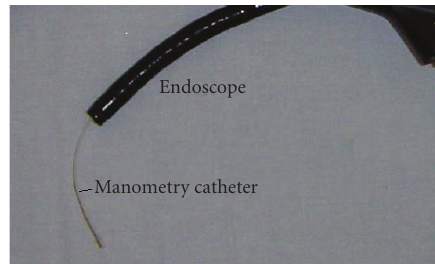
Figure 1: Picture of an endoscope with a manometry catheter placed through the biopsy channel.